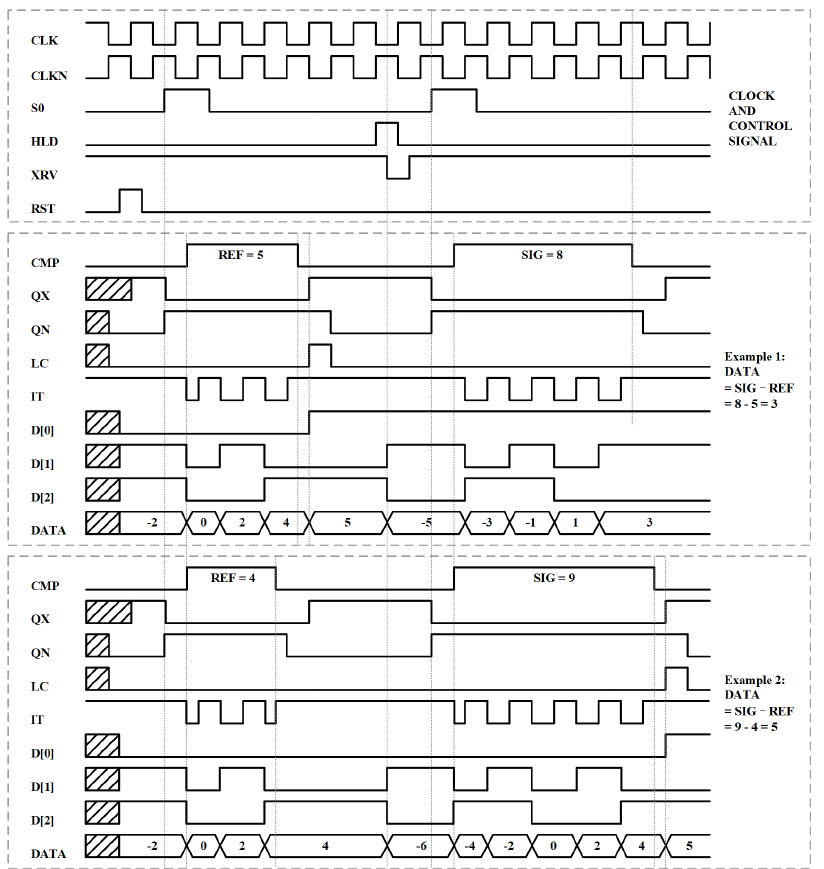
Figure 12. Timing diagram of the counter with two